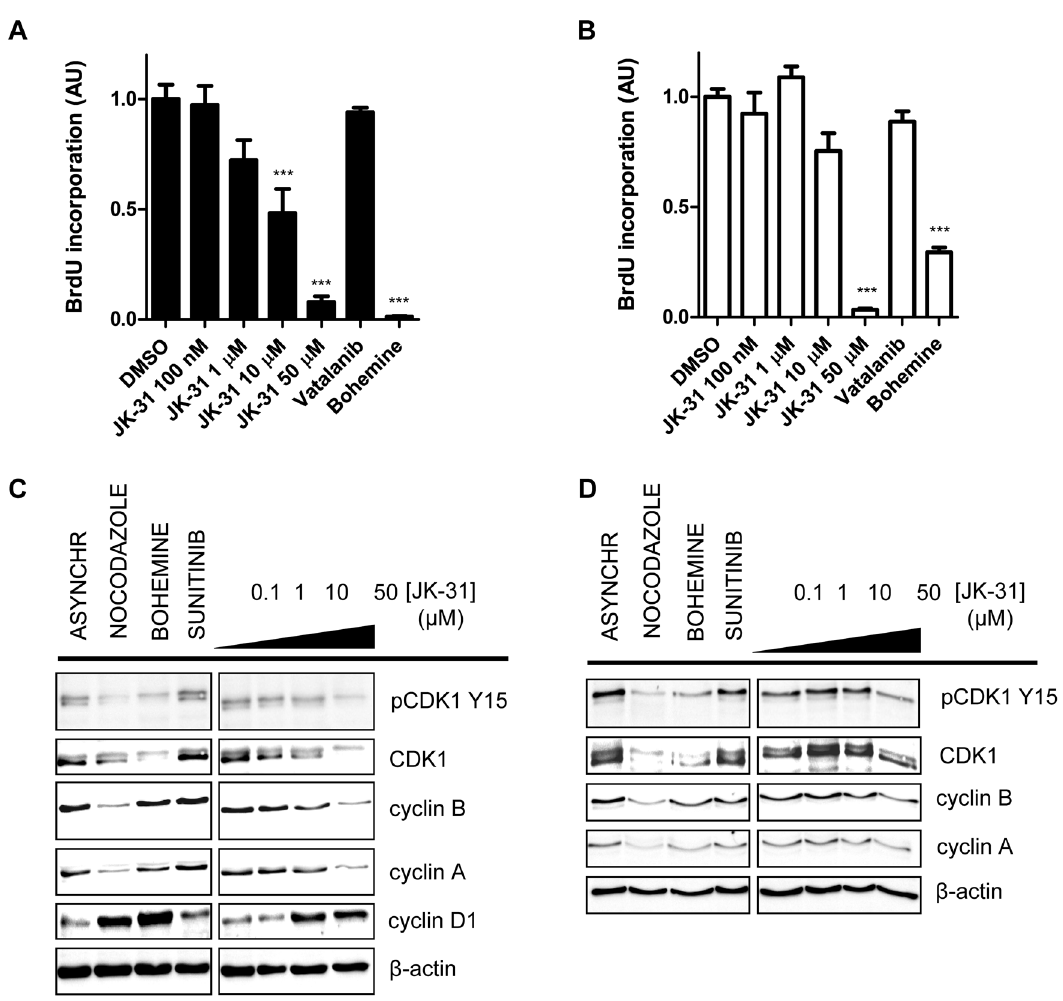
Figure 5. Effects of JK-31 on proliferation and cell cycle status of primary human endothelial cells and human breast cancer cells. (A) HUVECs and (B) MCF-7 cells were treated with DMSO, JK-31 (0.1, 1, 10, 50 m M), vatalanib (10 m M) or bohemine (10 m M) in full growth medium for 16 h followed by labeling with bromodeoxyuridine (BrdU; 10 m M) for 2 h and subsequent ELISA. Absorbance readings at OD 450 were normalized and expressed relative to DMSO control. Error bars represent 6 SEM (n=4; *** p , 0.001). (C) HUVECs and (D) MCF-7 cells were treated with nocodazole (200 nM), bohemine (10 m M), sunitinib (100 nM) or JK-31 (0, 0.1, 1, 10, 50 m M) for 48 h. Total cell lysates were prepared and immunoblotting carried out as described in Experimental Section. Membranes were probed for phosphorylated and total CDK1 in addition to cyclin A, B and D1 and a loading control ( a -tubulin). Representative immunoblots of three independent experiments shown.